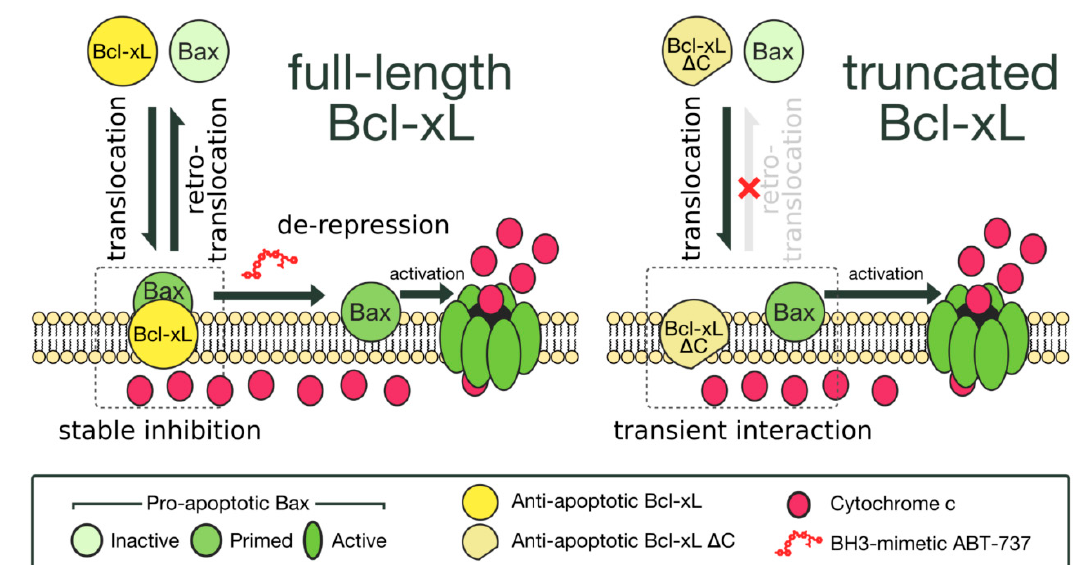
Figure 1. Schematic representation of the differential effect of BCL-xL on BAX dynamics (reproduced from [38]). Left : BAX is under a dynamic equilibrium between mitochondria and cytosol, owing to the processes of BCL-xL-driven translocation and retrotranslocation. Mitochondrial BAX is primed but remains inactive because of the interaction with BCL-xL. The addition of a BH3-mimetic (or the expression of a BH3-only partner) enables the derepression of the interaction and the full activation of BAX. Right : BCL-xL ∆ C stimulates BAX translocation but not BAX retrotranslocation, leading to a higher mitochondrial BAX content. Furthermore, the interaction between BAX and BCL-xL ∆ C is weaker than with BCL-xL, and BAX can therefore be activated in the absence of BH3-only protein or BH3 mimetics.